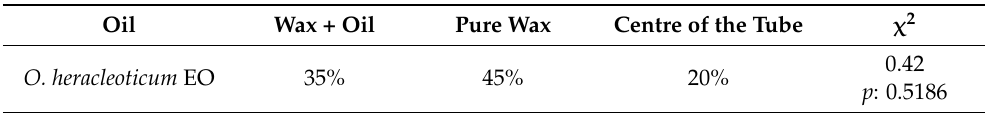
Table 4. Percentage of times V. destructor mites were found in one tube location compared to another, after 90 min. Oil Wax + Oil Pure Wax Centre of the Tube χ 2 O. heracleoticum